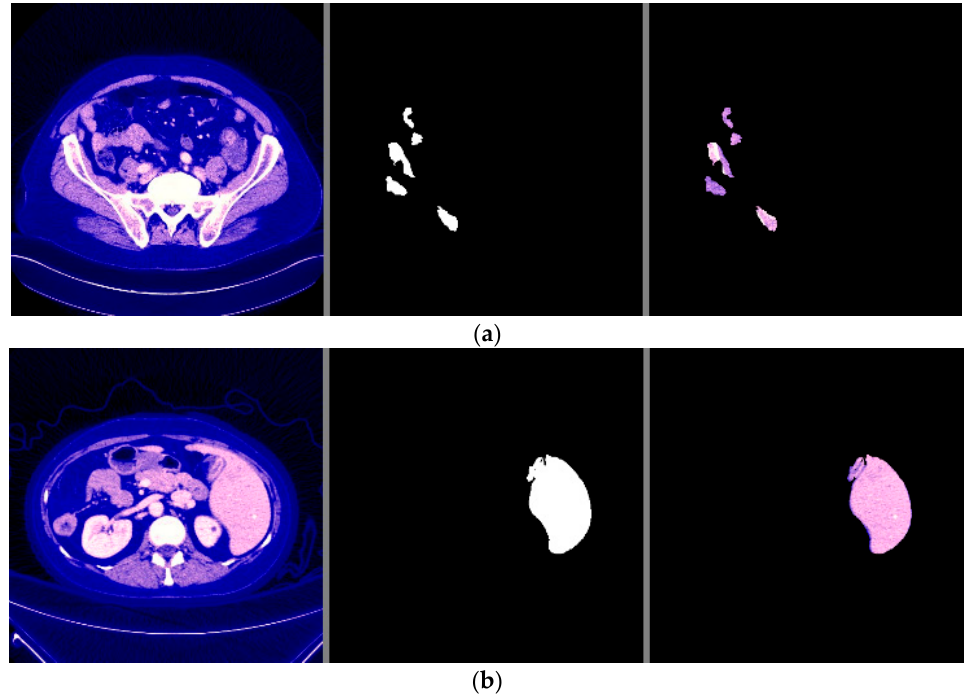
Figure 9. The visual results of the second model for cancer detection on LiTS dataset : ( a ) normal case (no tumor detection); ( b ) abnormal case (tumor detection). The loss curve of the second model is also shown in Figure 10.